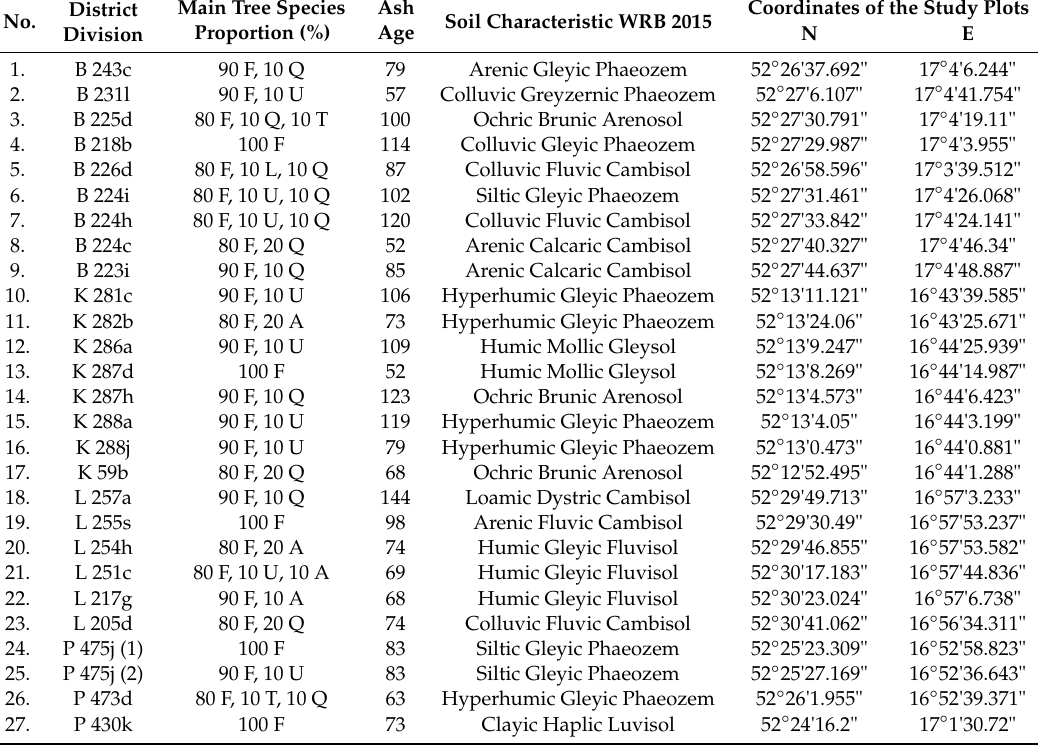
Table 1. Basic characteristics of the study plots. Reference soil groups and their principal and supplementary qualifiers follow the IUSS Working Group WRB [42]. Forest districts: B (Babki); K (Konstantynowo); L (Łopuch ó wko); P (Pozna´n Communal Forests). Species abbreviations: A ( A. glutinosa ); F ( F. excelsior ); T ( T. cordata ); U ( U. laevis , U. glabra ); Q ( Q. robur ). Coordinates follow